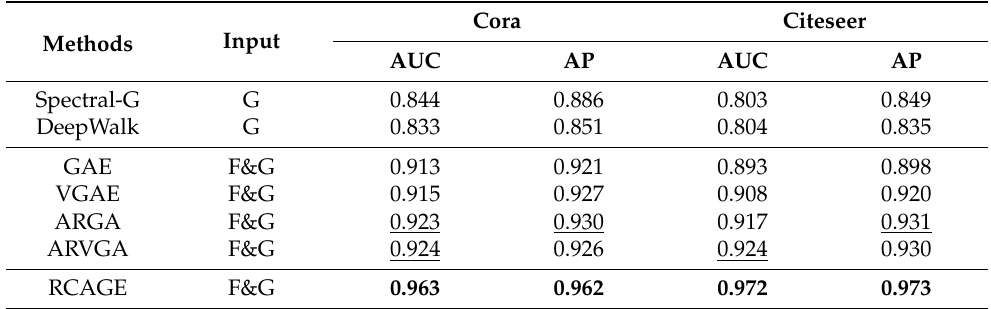
Table 5. Link prediction